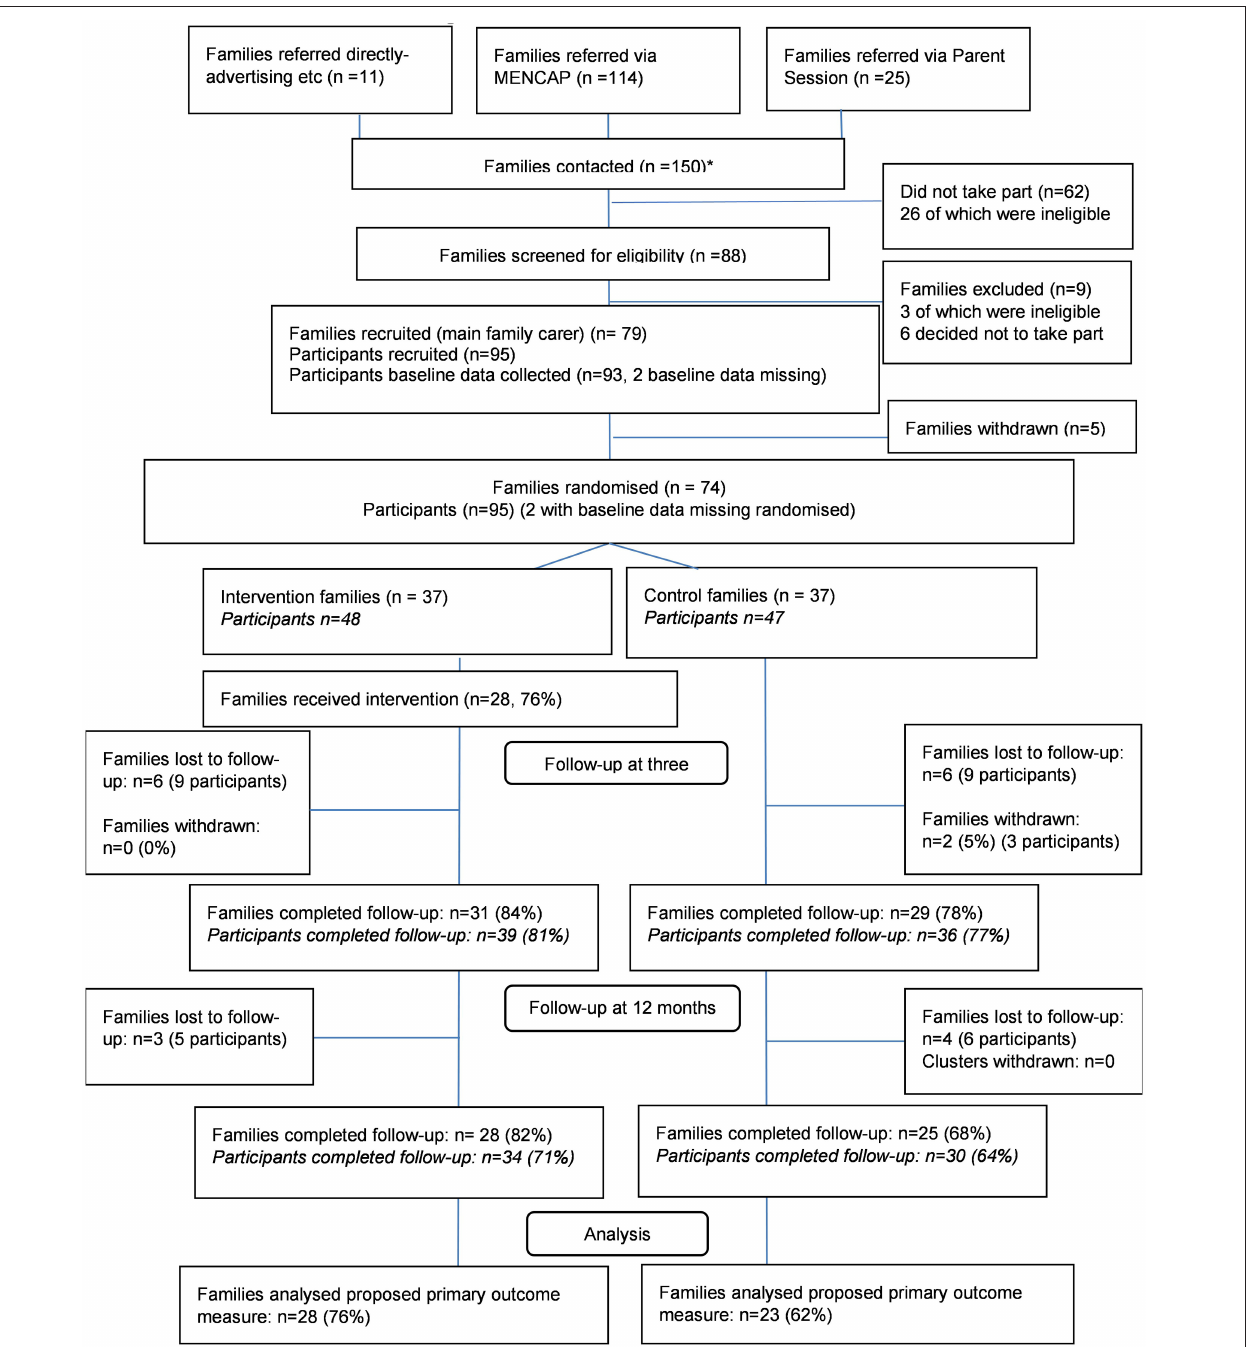
FIGURE 1 | E-PAtS CONSORT diagram. * A total of 150 families were contacted in the study. One of the sites recruited families in 2 rounds, and some of the families (n = 16) referred from this site were referred for both the first and second round (if they were not recruited on the first round).